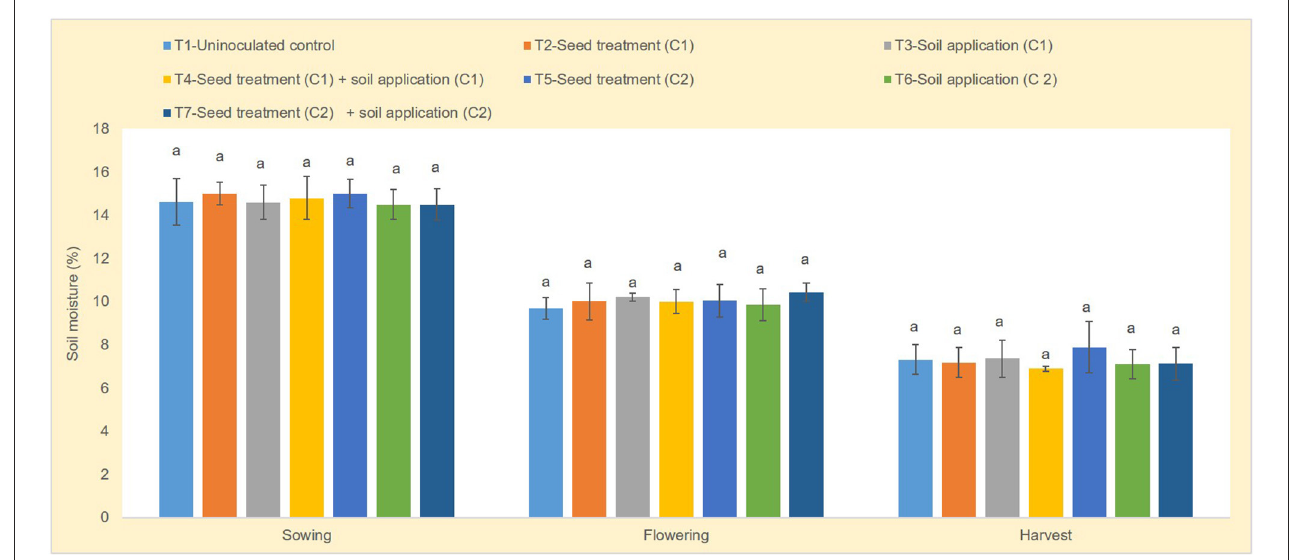
FIGURE1 Soil moisture (%) at different stages of crop growth at Ballowal Saunkhri (Punjab). Sowing ( p = 0.92), flowering ( p = 0.53), and harvest ( p = 0.67); error bars indicate standard error. The different alphabets on the top of error bars indicate the significant difference.